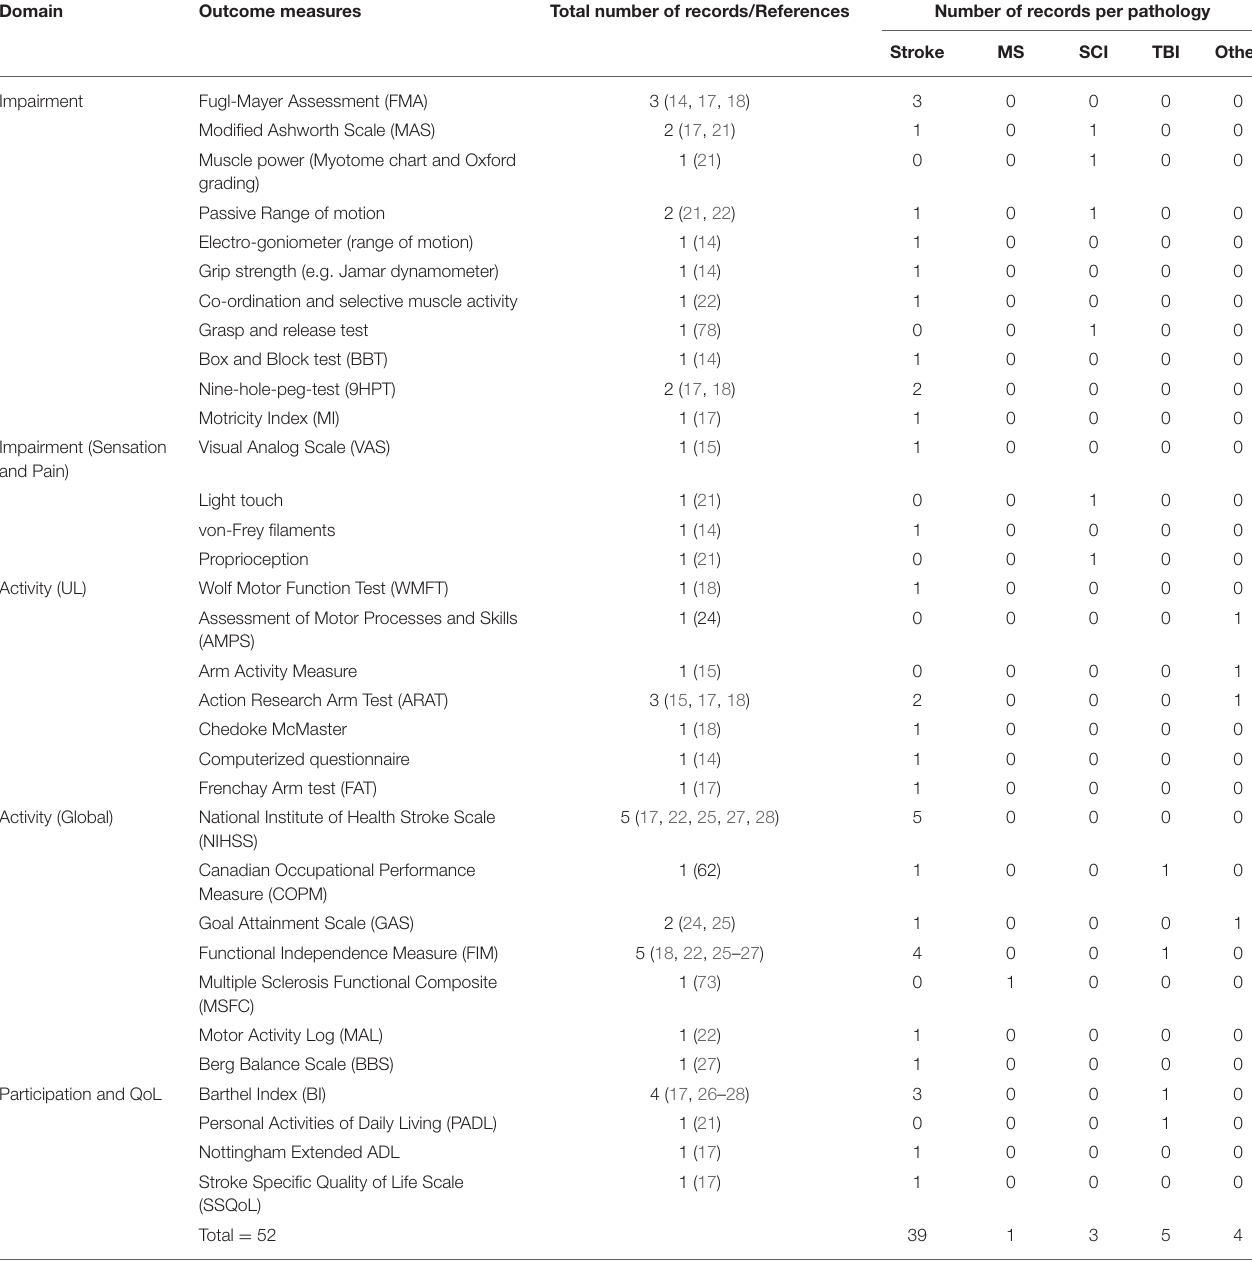
TABLE 3 | Frequency with which different outcome measures were recommended in total and for each pathology included in the review.